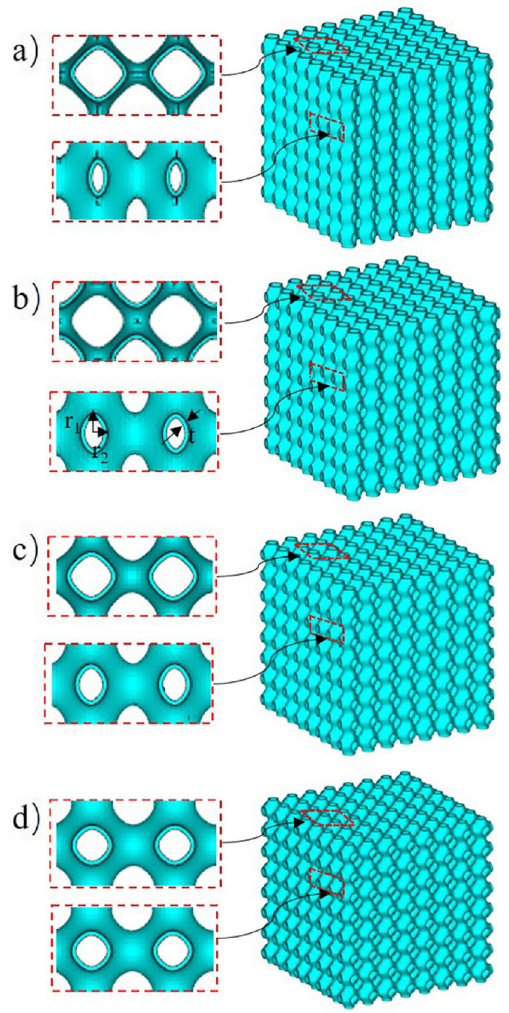
Figure 1. CAD diagram of four groups of